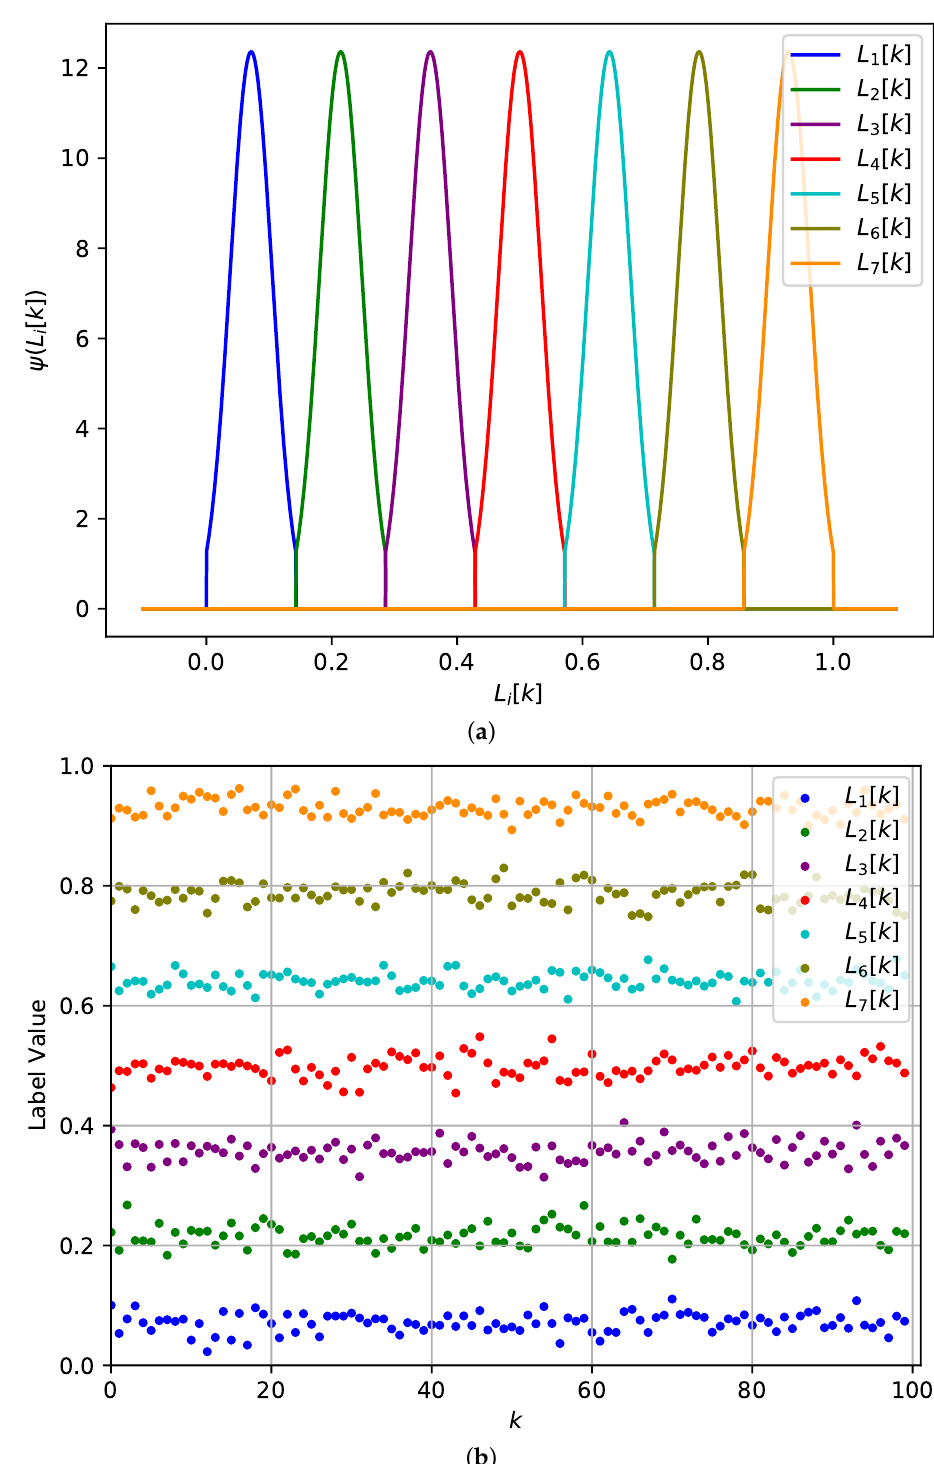
Figure 7. Random labels of 7 agents. ( a ) The sampling interval of each node. ( b ) The distribution of label values at each time